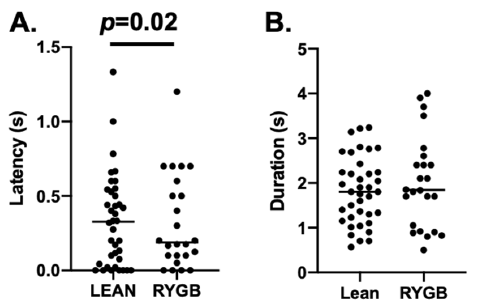
Figure 5. ( A ) Median latency for Lean = 0.327; RYGB = 0.188; Mann–Whitney U test p = 0.020 ( B ) Median duration for Lean = 1.800 s; RYGB = 1.842 s. Only 5L responses were included. Electrophysiological recordings from the NTS in RYGB rats showed the same heter ‐ ogeneity of firing patterns as have been recorded [25,27]. That is, in addition to taste ‐ re ‐ sponsive cells, there were lick cells, lick ‐ bout cells, anti ‐ lick cells, and non ‐ responsive cells. The firing rate in lick cells rhythmically followed the lick pattern with peak firing bursts at different times in the lick cycle depending on the cell [37]. Anti ‐ lick cells were active until the lick bout began and then became relatively quiescent while the rat was licking, whereas lick bout cells showed the opposite pattern, i.e., they increased their firing rate when the rat began to lick but decreased their firing rate when the rat stopped licking. The relative frequencies of these styles of activity were not statistically different between RYGB and Lean rats, as shown in Figure 3B (chi ‐ squared = 3.230, df = 4, p = 0.5201; RYGB N = 391 cells; Lean n = 438 cells). Figures showing examples of these cell types can be found in [25]. 3.3. Lick ‐ Related Firing and Lick Behavior In most taste ‐ responsive cells in Lean rats, the firing rate increases above spontane ‐ ous levels as the animal begins a lick bout; however, this was not the case with taste cells in RYGB rats. Figure 6 illustrates this point. Average spontaneous firing rate was calcu ‐ lated based on multiple 14 s intervals during which the rat was not licking. The first three seconds of this interval were excluded from the analyses since they may have included taste ‐ evoked activity; the last one second of activity was also excluded since it might have contained activity that reflected preparation to lick. Spontaneous firing rates were signif ‐ icantly greater in taste cells from RYGB rats compared with those in Lean rats ( t (104) = 4.042, p < 0.0001). Average baseline firing rates were based on the firing rate in the 1 s just prior to the first taste stimulus lick, averaged across all taste stimulus trials. Mean baseline firing rates did not differ between taste cells in RYGB rats vs those in Lean rats ( t (104) = 0.441, p = 0.66). Thus, taste cells in RYGB rats were more spontaneously active than taste cells in Lean rats and did not react to the onset of licking by further increasing their firing rate as did cells in Lean rats.